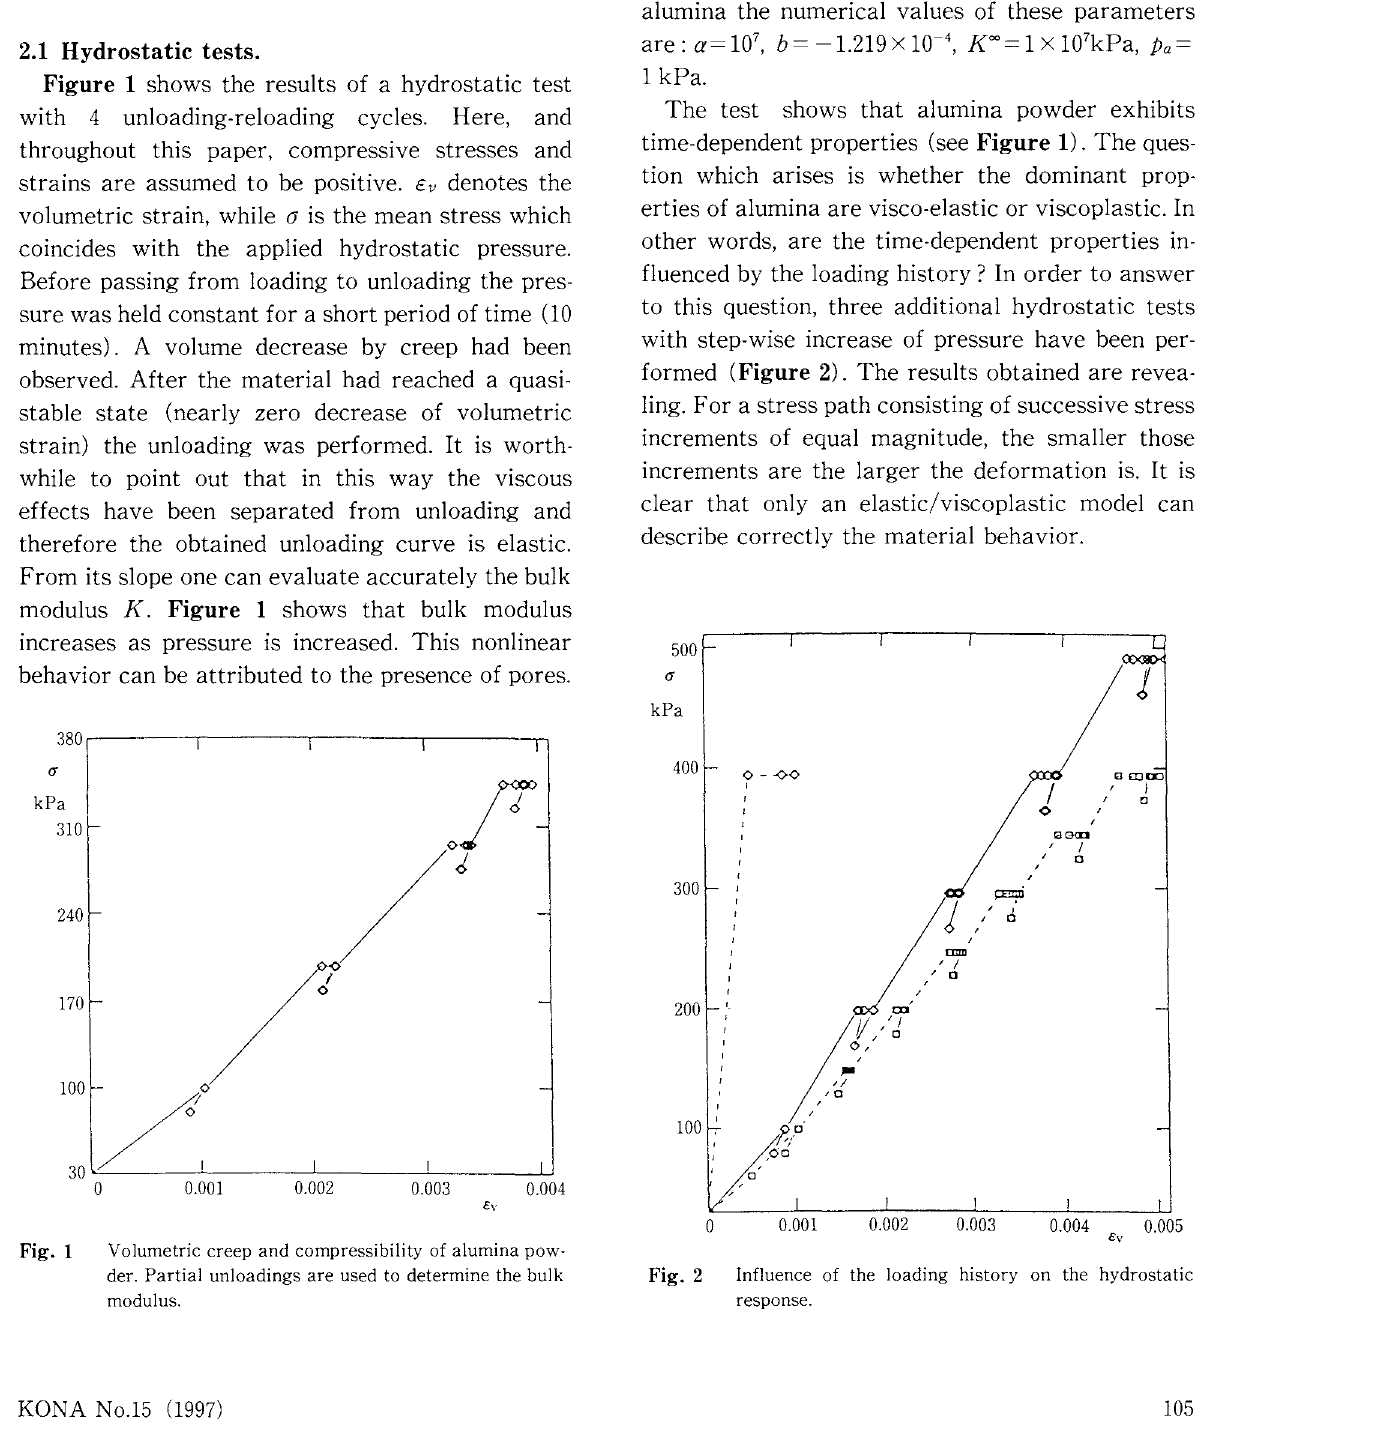
Volumetric creep and compressibility of alumina pow der. Partial unloadings are used to determine the bulk modulus.